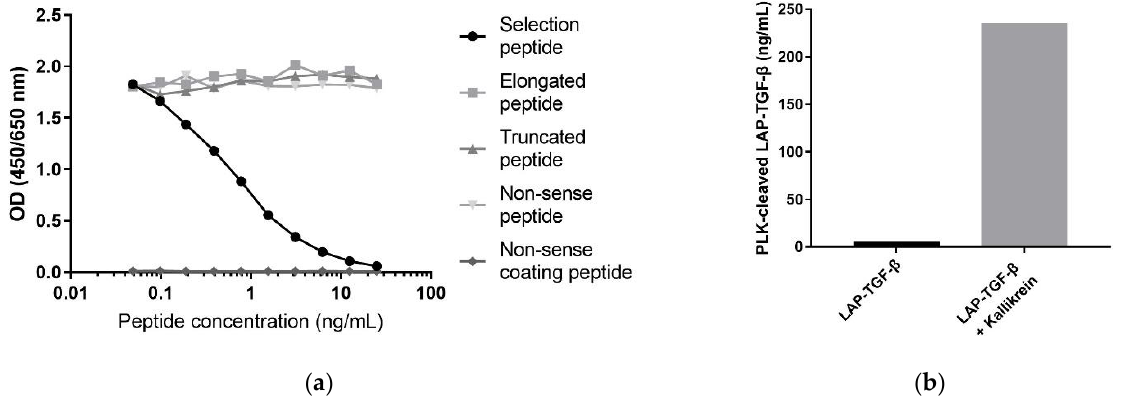
Figure 2. Assay specificity towards PLK-cleaved LAP-TGF- β : ( a ) Inhibition curve for the selection peptide (LASPP- SQGEV), elongated peptide (RLASPPSQGEV), truncated peptide (ASPPSQGEV), non-sense selection peptide (PNASPLLGS), and a non-sense coater peptide (YPNASPLLGS-K-(Biotin)). The peptides were diluted in 2-fold dilution series starting from 25 ng/mL. ( b ) PLK-cleaved LAP-TGF- β measured after one hour incubation of LAP-TGF- β with or without